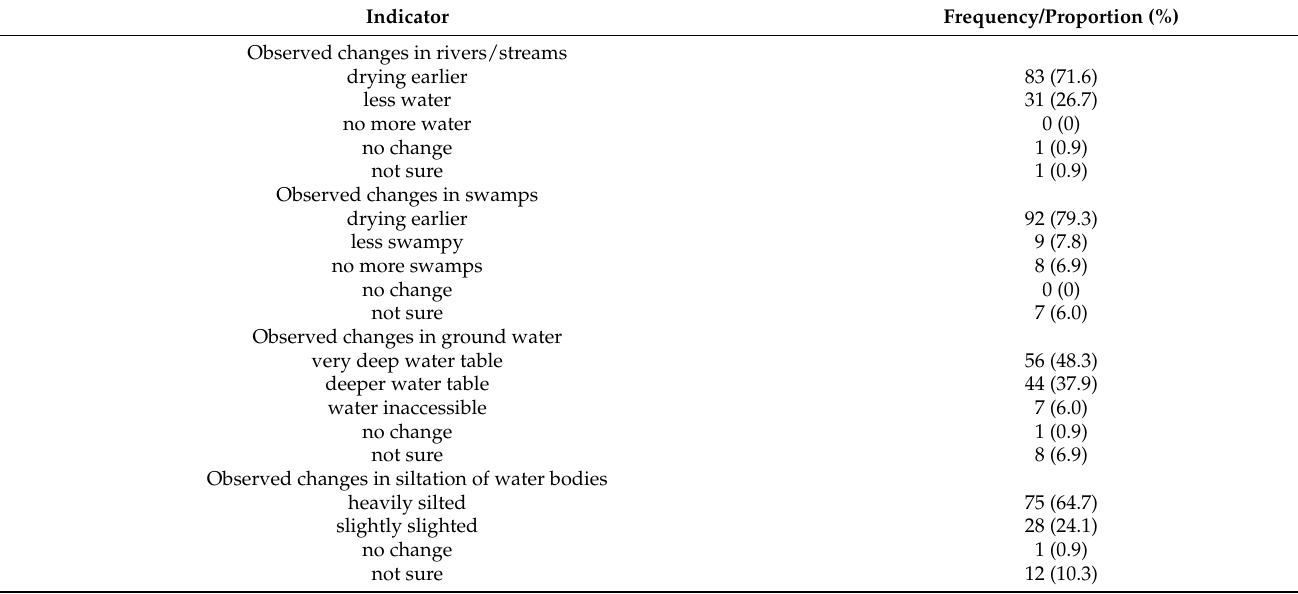
Table 3. Observed changes in the hydrological system in Malipati,